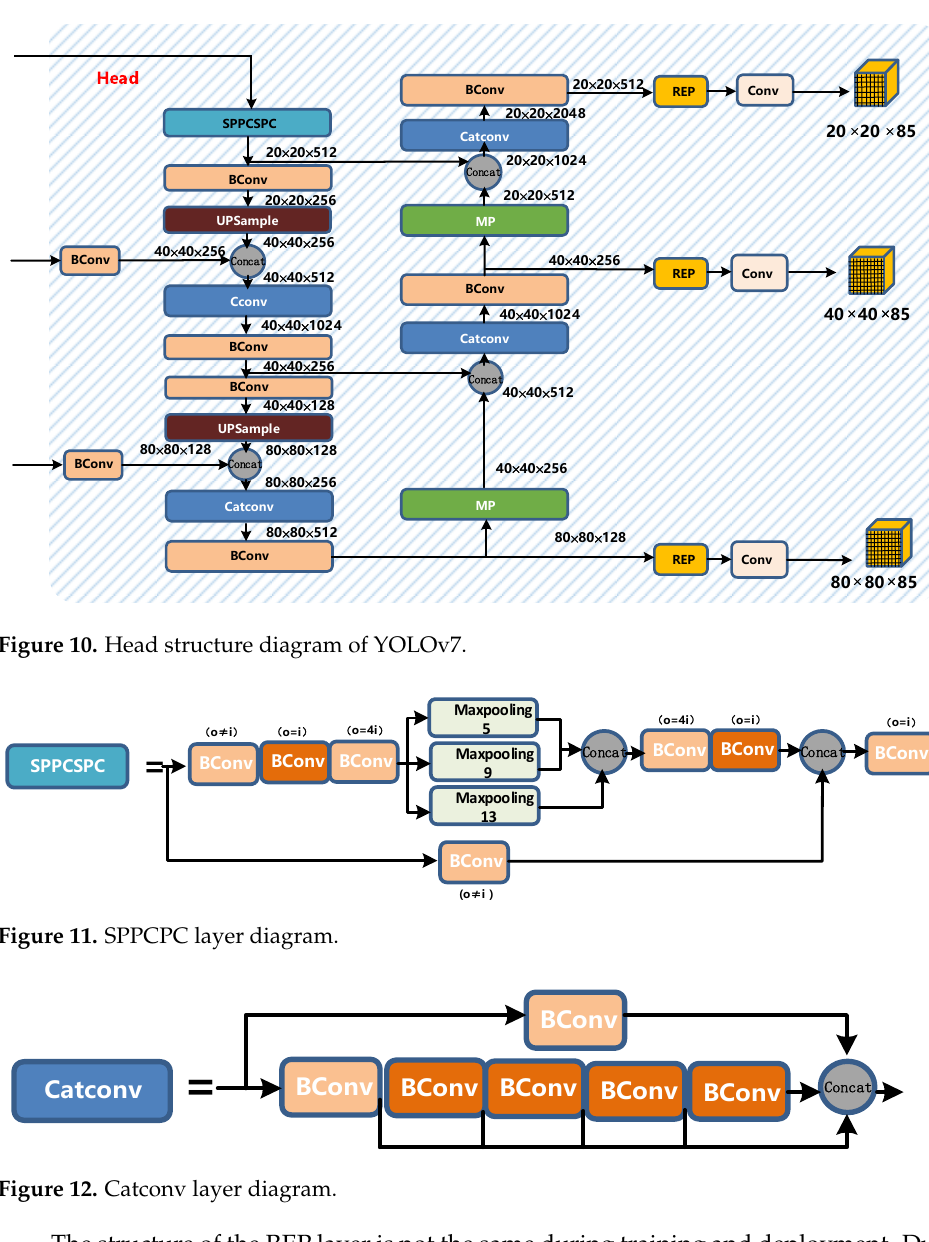
Figure 12. Catconv layer diagram.